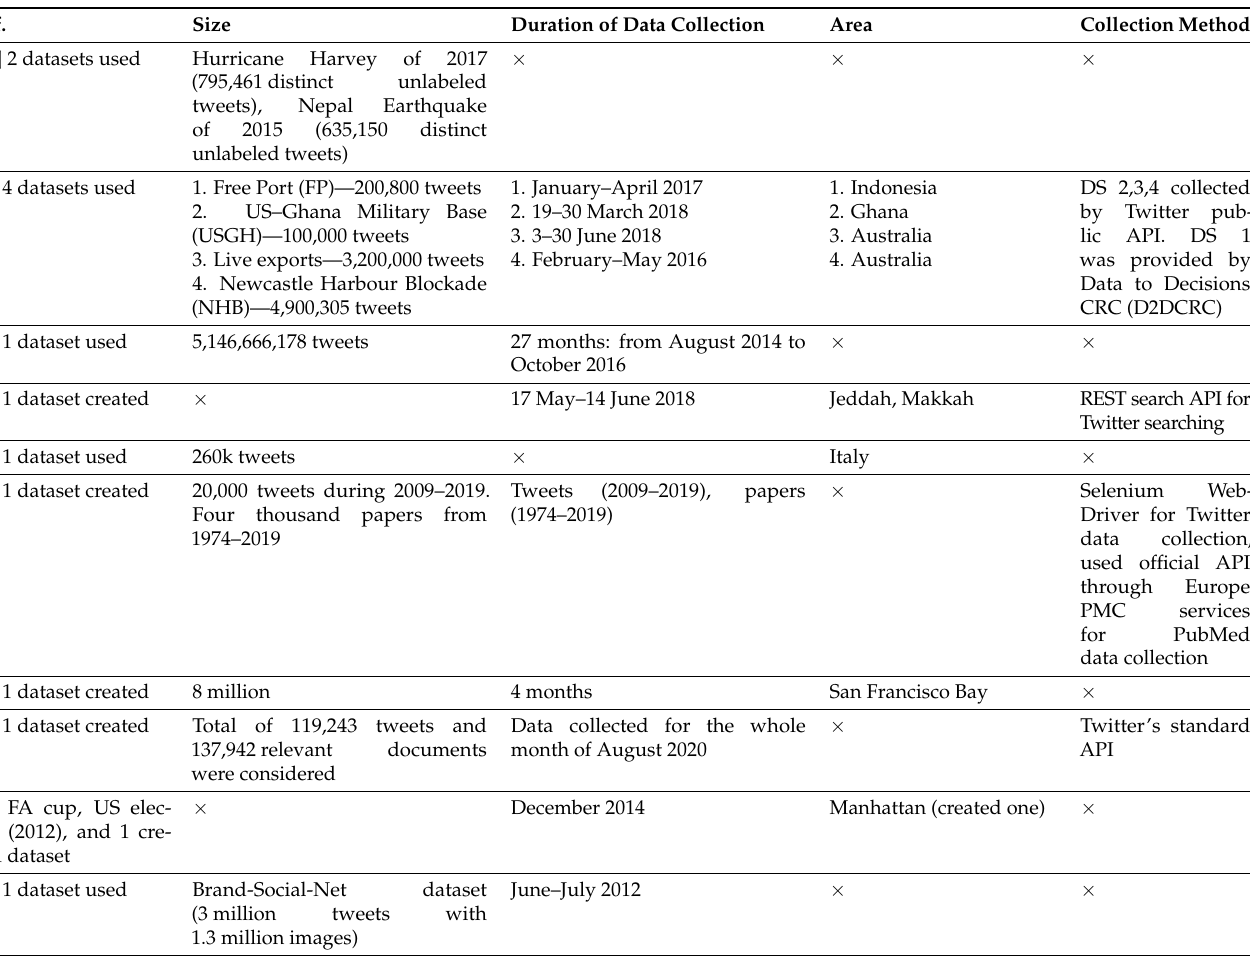
Table 6. Other-approach-based articles’ used datasets and their related information: presenting total datasets created, size of datasets, duration of data collection, geographical area, and their collection